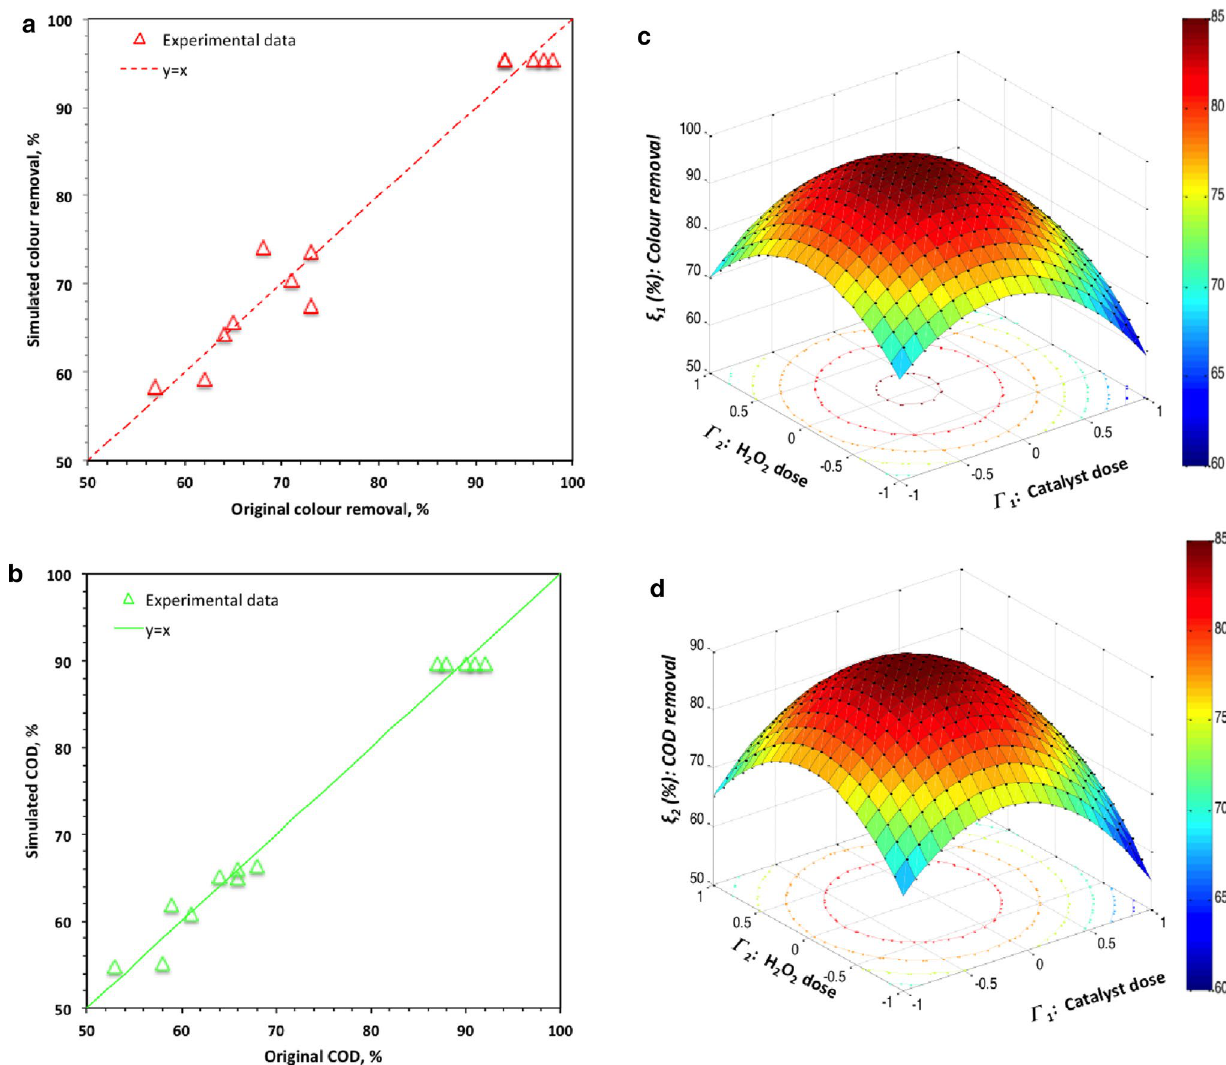
Fig. 7 Central composite design (CCD) optimization of Mn 0.6 Zn 0.4 Fe 2 O 4 /H 2 O 2 /UV system: ( a ) Original and estimated ζ 1 response plot; ( b ) Original and estimated ζ 2 response plot; ( c ) 3-D surface and contour plot of ζ 1 model; ( d ) 3-D surface and contour